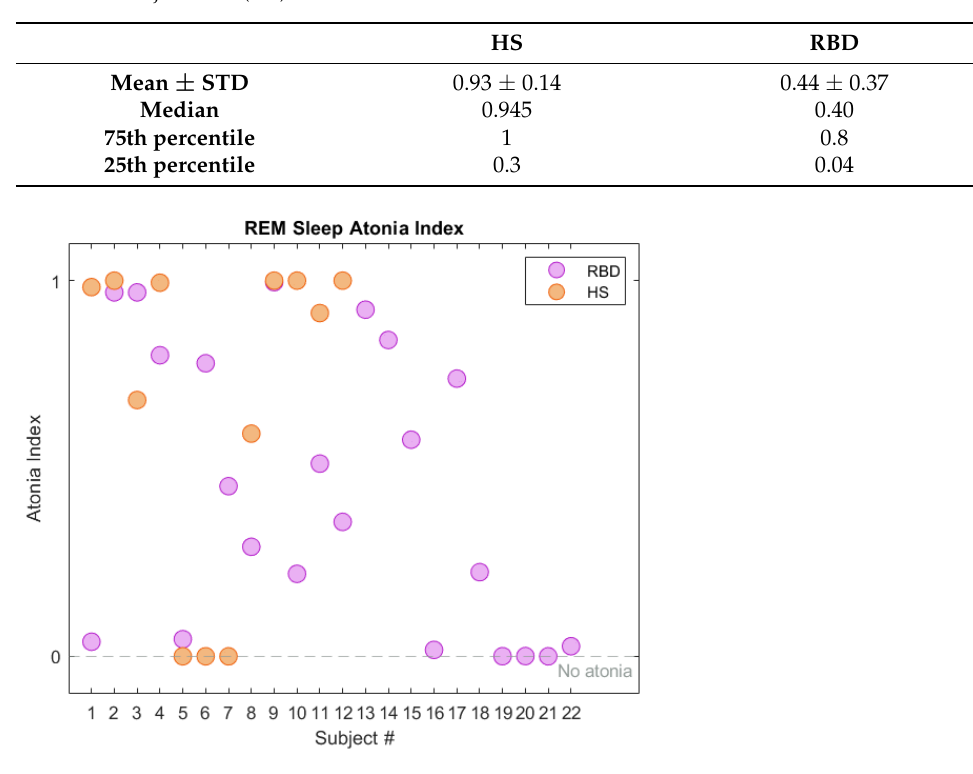
Figure 4. REM Sleep Atonia Index (RAI) in healthy subjects (HS, orange) and RBD (purple), in the CAP Sleep Database. The gray dashed line represents lack of REM atonia.